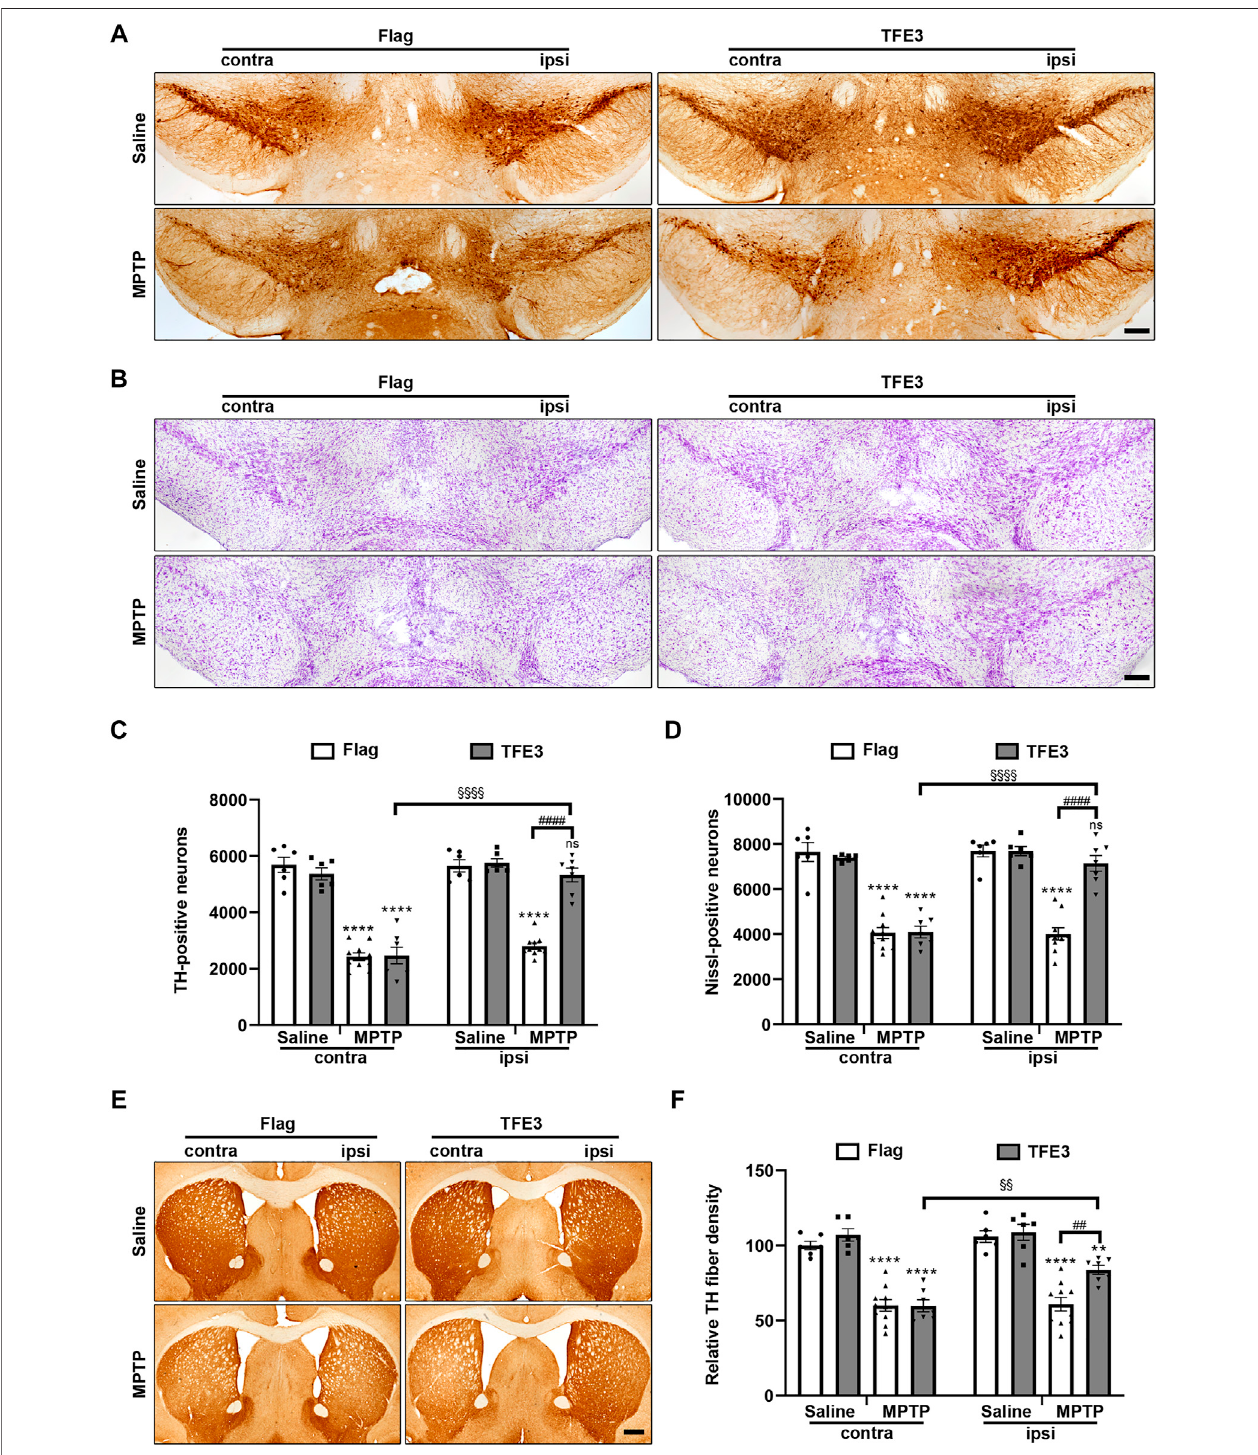
FIGURE6| TFE3overexpressionalleviatesdopaminergicneuronslossfromMPTPneurotoxicity. (A,B) ImmunohistochemicalTHstaining(A)andNisslstaining(B) of midbrain sections from Saline- and MPTP-treated mice overexpressing Flag or TFE3. Scale bars: A, B 200 μ m. (C, D) Stereological cell counts of TH-positive (C) and Nissl-positive (D) neurons in the SN. (E) Immunohistochemical TH staining of striatal sections from Saline- and MPTP-treated mice overexpressing Flag or TFE3. Scale bars: 500 μ m. (F) Quantitation of optical densities of the striatal TH immunostaining; n (cid:1) 6 – 10 per group. Data are expressed as the mean ± SEM. ** p < 0.01, **** p < 0.0001, ## p < 0.01, #### p < 0.0001, §§ p < 0.01, §§§§ p < 0.0001, ns, not signi fi cant, ANOVA followed by Tukey ’ s multiple comparisons test.